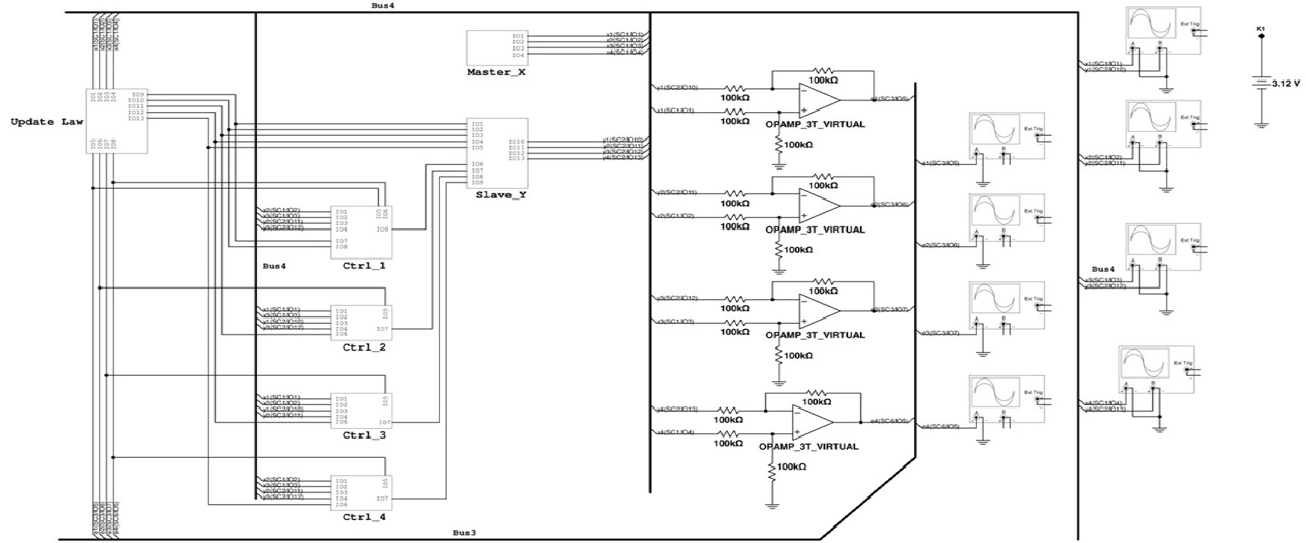
Figure 8. Circuit configuration of the whole adaptive electronic circuits.